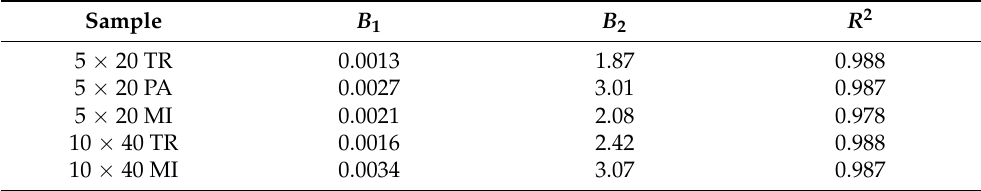
Table 2. The values of coefficients B 1 , B 2 and R 2 from Equation (4) obtained for individual samples.